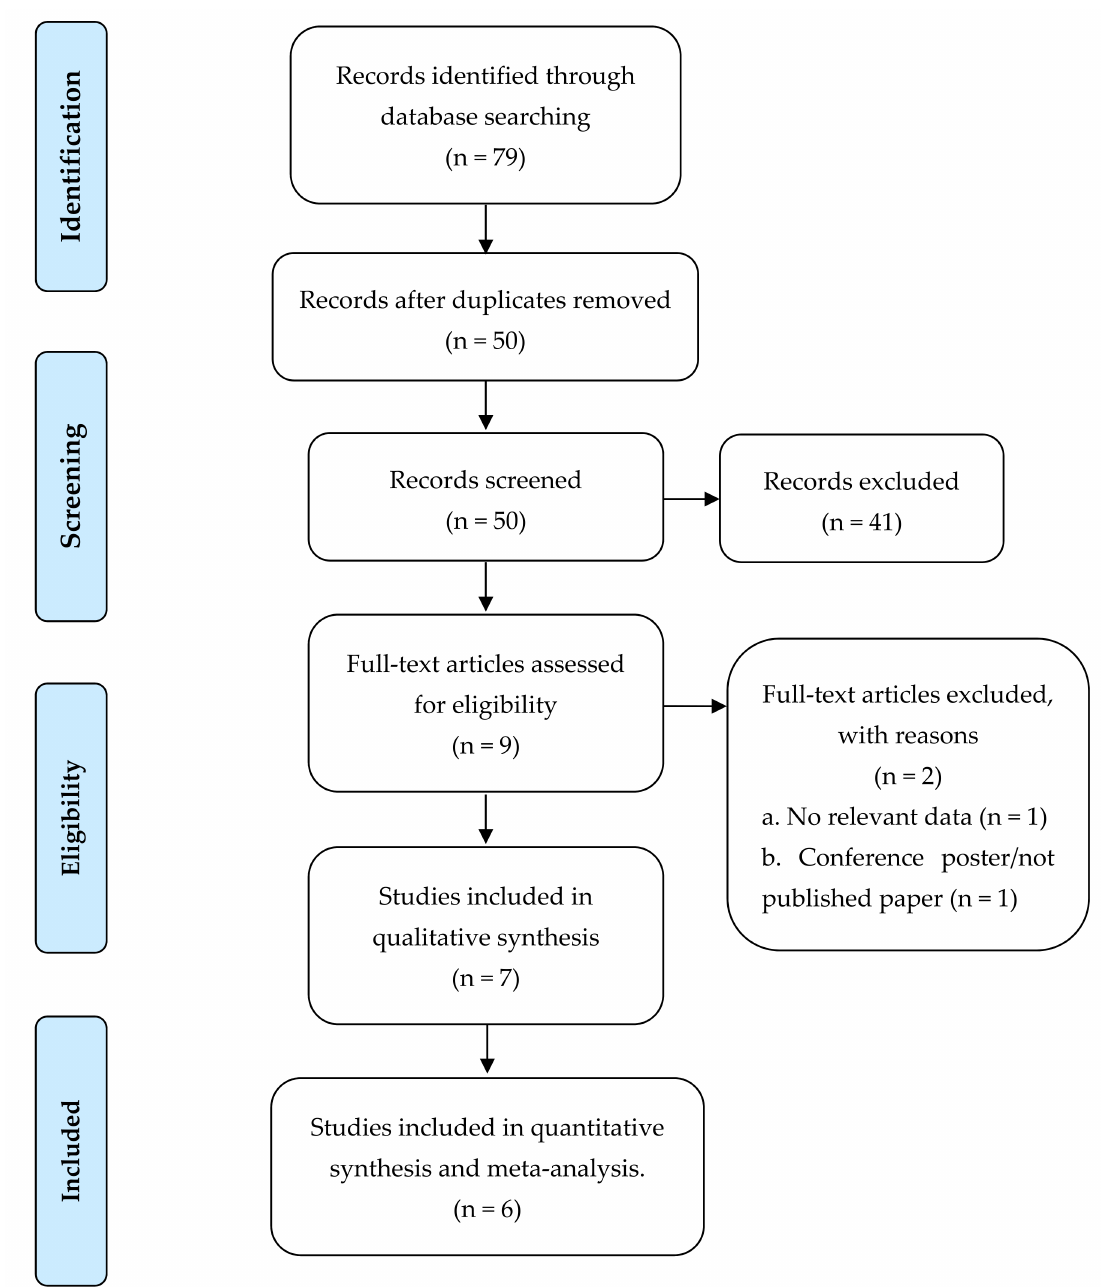
Figure 1. PRISMA flow diagram for a systematic literature review on malnutrition among children and adolescents with CP in